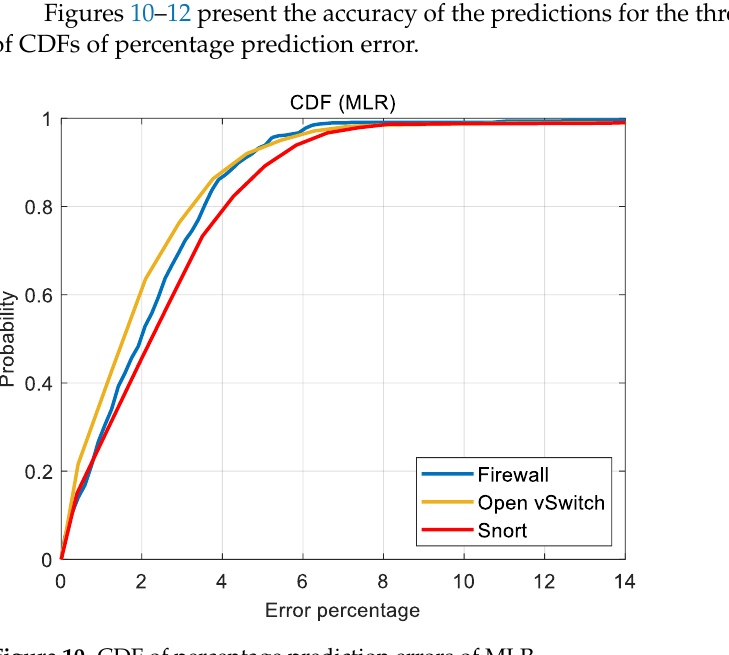
Figure 10. CDF of percentage prediction errors of MLR.